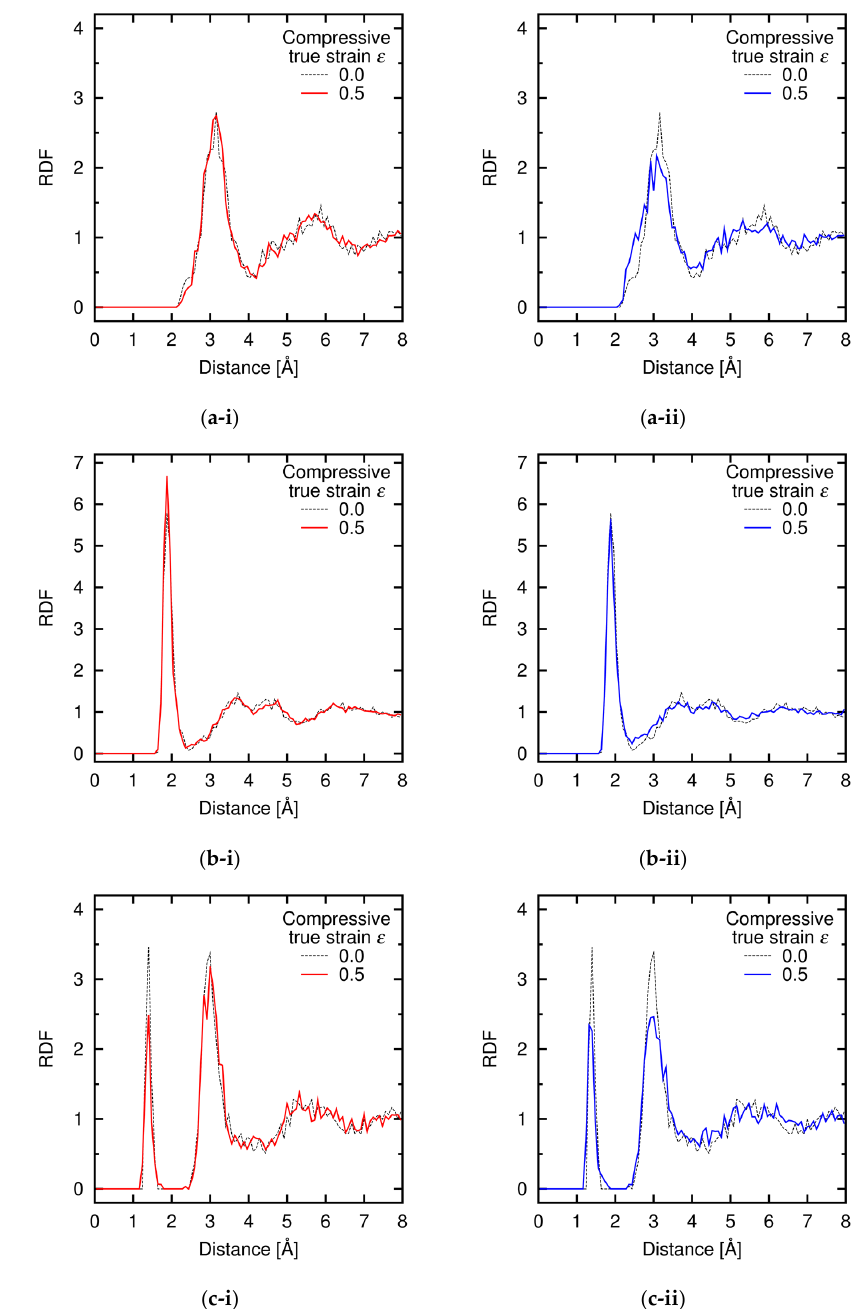
Figure A3. RDFs under d ε / dt -constant conditions for ( a ) Si-Si, ( b ) Si-C, and ( c ) C-C at ( i ) d ε / dt = 2 × 10 − 3 ps − 1 (Region I) and ( ii ) d ε / dt = 2 × 10 − 1 ps − 1 (Region II) before and after deformation.